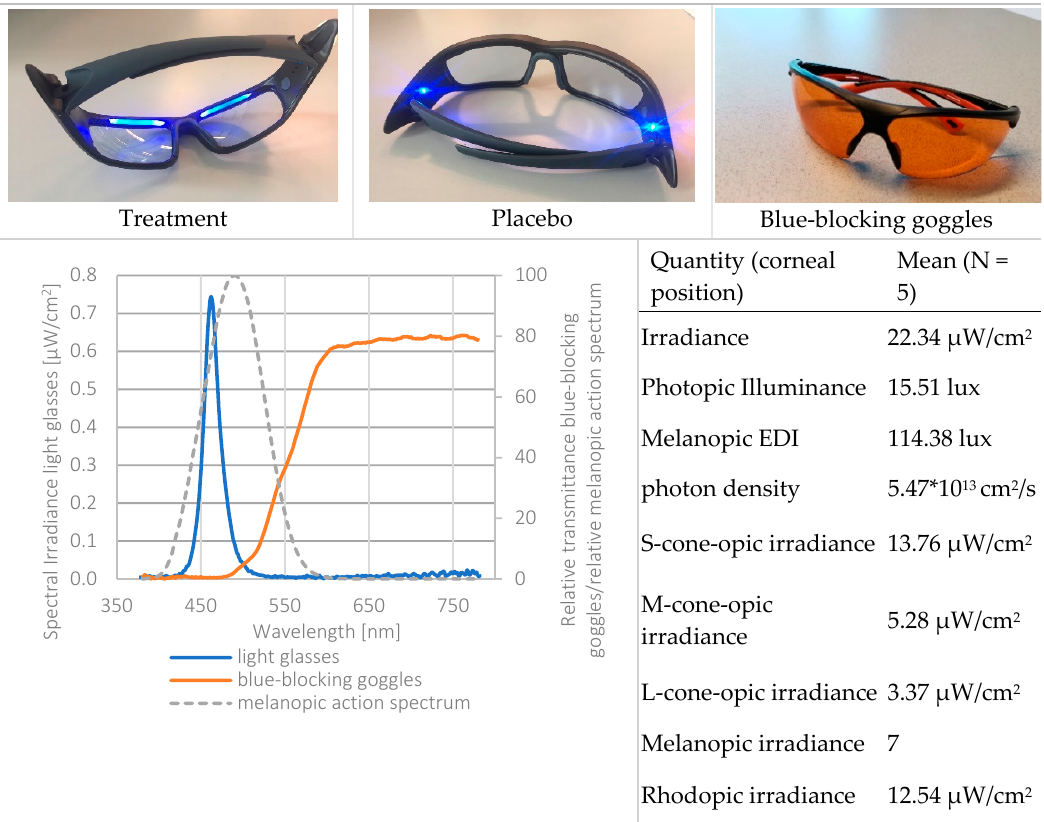
Figure 5. Top: light glasses (treatment, placebo) and the blue-blocking goggles. Bottom left: spectral power distribution of the treatment light glasses, melanopic irradiance, and the spectral transmission of the blue-blocking goggles. Light measurements were performed at corneal position, using a realistic head model. Bottom right: radiometric and photometric properties of the treatment light glasses. Calculations through the CIE S 026 Toolbox—beta version E1.05 [39].